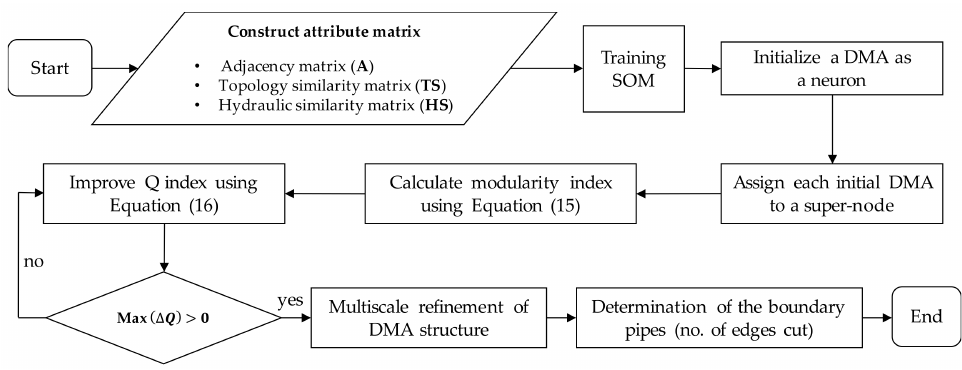
Figure 3. Flowchart of the clustering